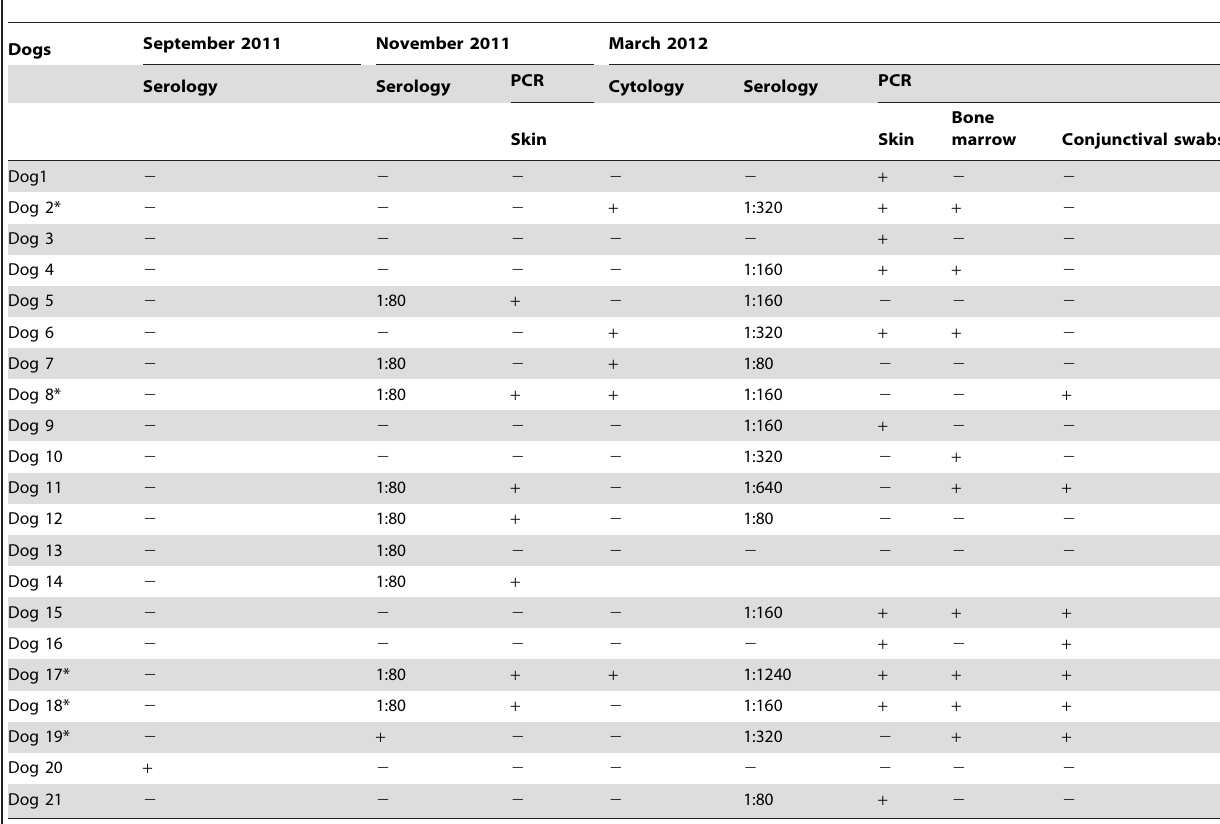
Table 2. Results at IFAT (the highest dilution titre is reported), cytological examination and PCR results for skin, bone marrow and conjunctival swabs of positive dogs at follow-up time points and the final test period.